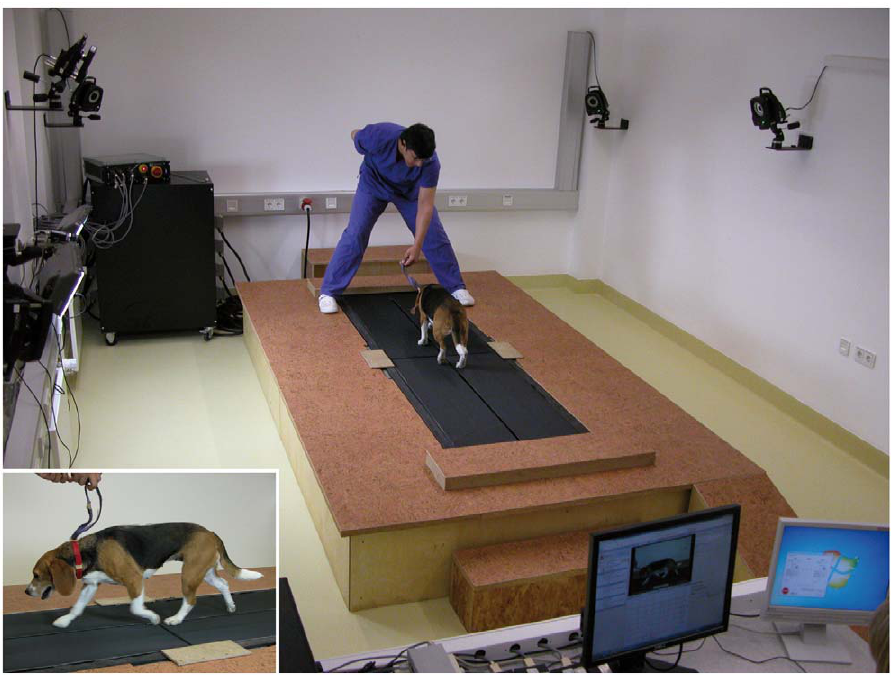
Figure 1. Experimental set-up used in the current study. The dogs walked and trotted at their preferred speed on the instrumented four-belt treadmill, which allowed for the synchronous collection of single limb forces before and after a distal load-bearing lameness was induced in the right forelimb (see inset).